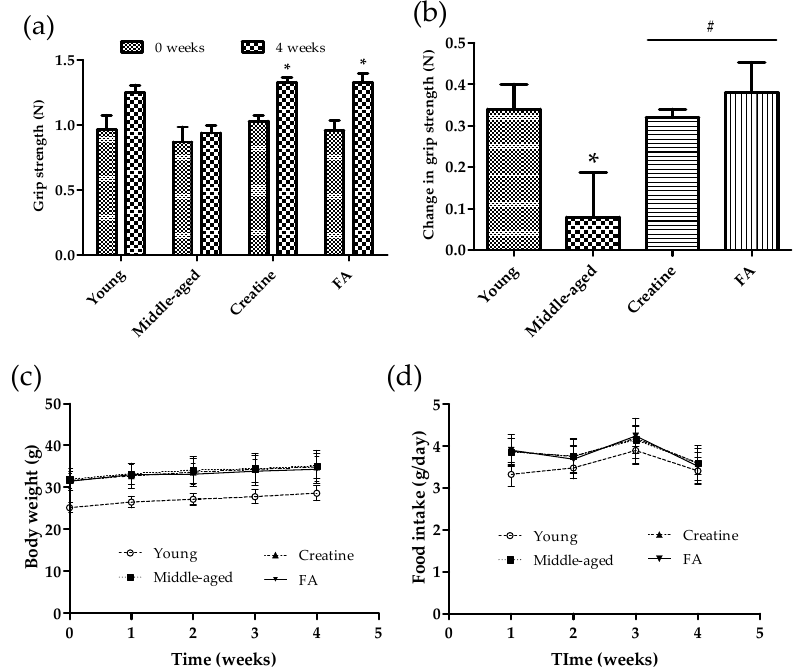
Figure 1. Effect of FA on grip strength. The forelimb grip strength of each mouse was measured at weeks 0 and 4 ( a ). Data are expressed as the mean ± SD ( n = 5 mice per group), p -values < 0.05 (*) as compared with week 0. Muscle strength improvement from week 0 to week 4 ( b ), daily food intake ( c ), and weekly body weight ( d ). Data are expressed as the mean ± SD ( n = 5 mice per group), and p -values < 0.05 (*) as compared with the young control or p -values < 0.05 (#) as compared with the middle-aged control